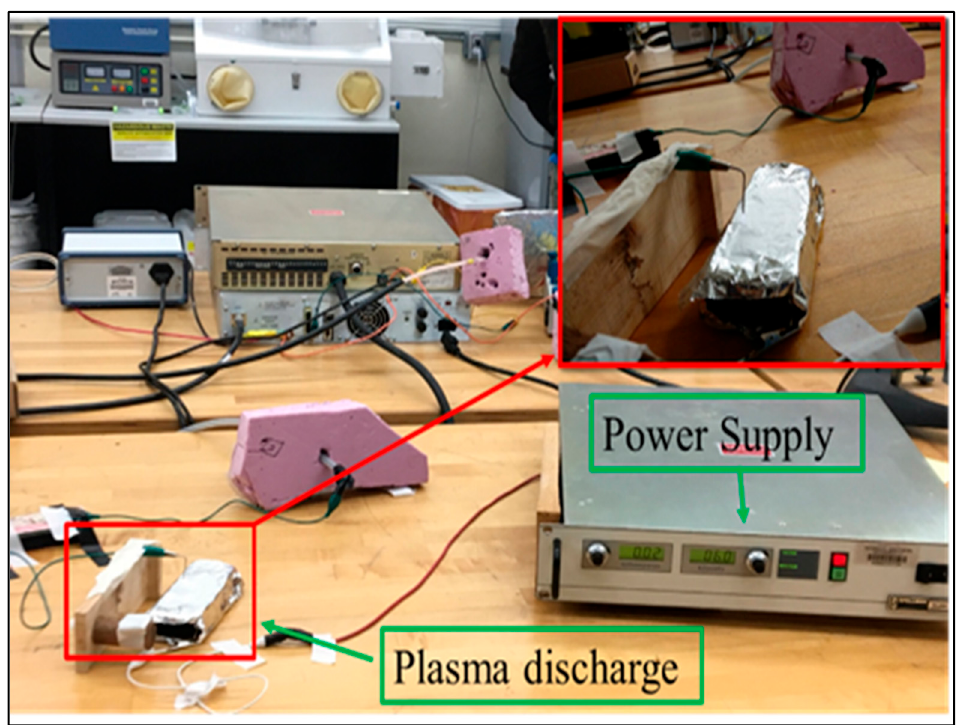
Figure 2. Set-up for corona treatment.